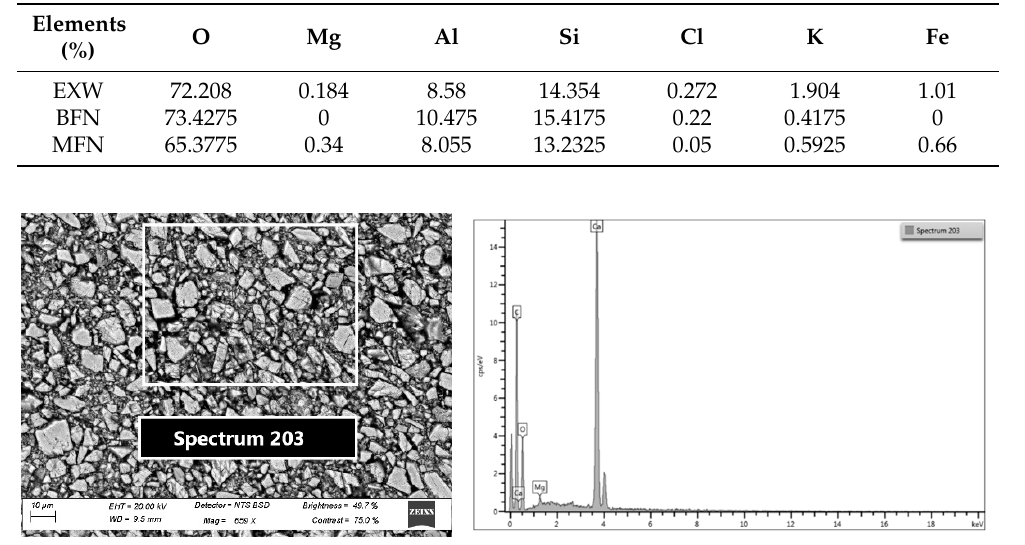
Figure 6. SEM images of limestone powder and the EDS analysis from the spectrum (the insert table is the average of 12 other spectra). Table 7. EDS average elemental results from 28 spectra each.